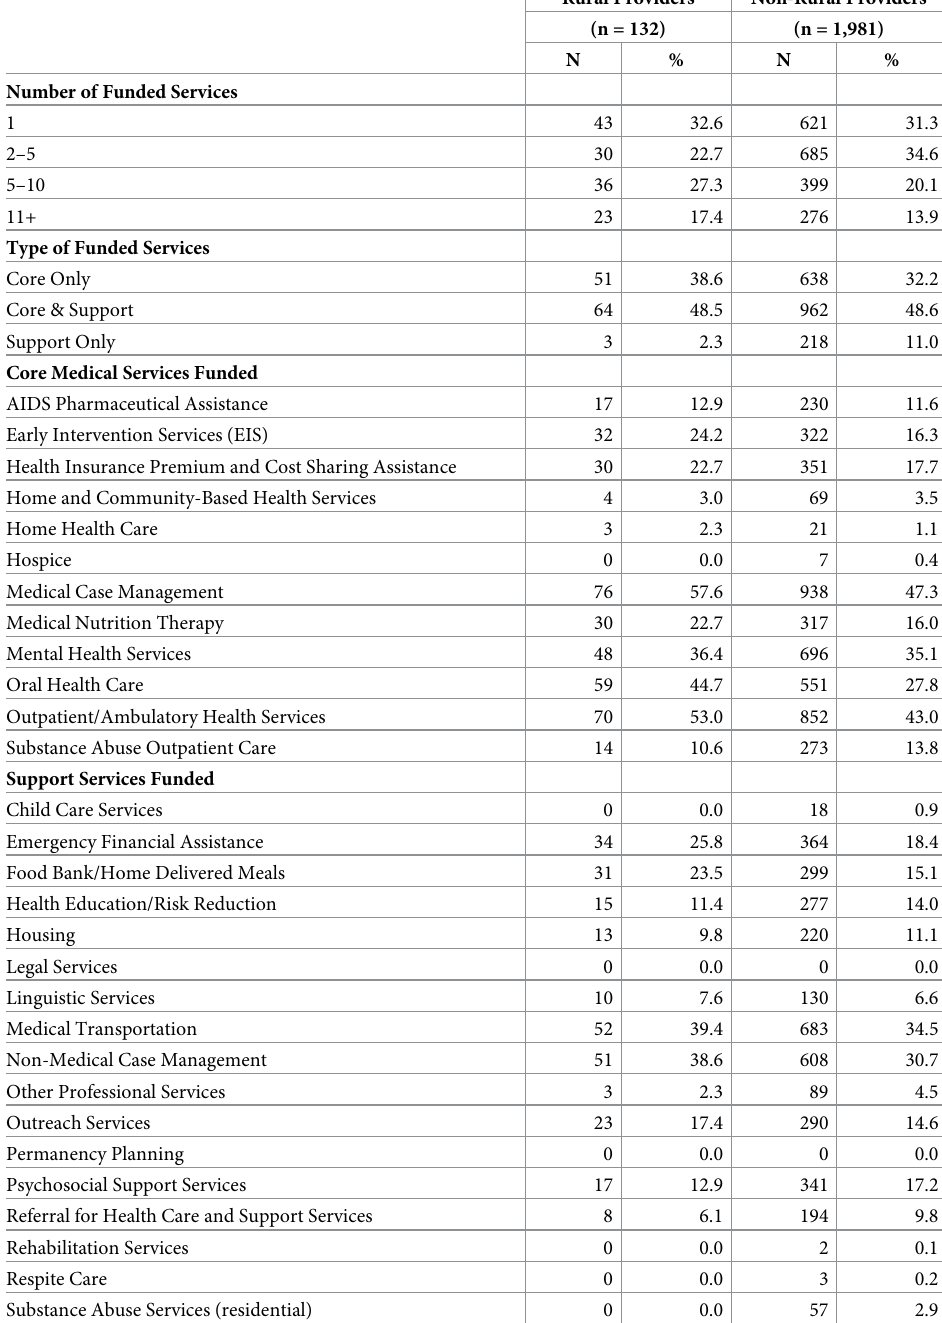
Table 3. RWHAP funded services by rural and non-rural RWHAP Providers,